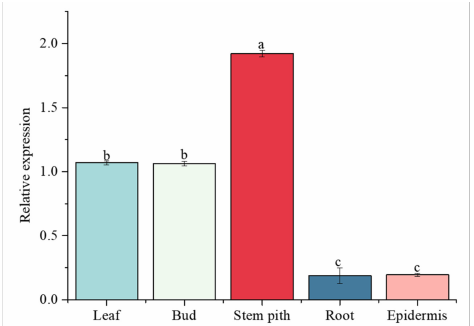
Figure 9. Expression of ScGH3-1 genes in the different tissues of sugarcane ROC22. Other sugarcane tissue data are normalized with sugarcane root. All the data points are means ± standard deviation ( n = 3). Bars superscripted by different lower-case letters indicate significant differences, as deter- mined by Duncan’s new multiple range test ( p -value < 0.05).